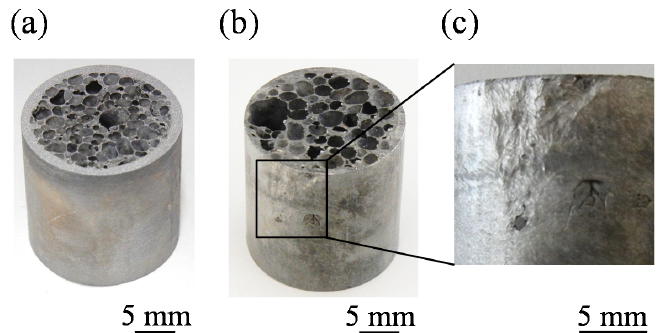
Figure 4. Fabricated ADC12 ‐ foam ‐ filled A1050 tube with holding times of ( a ) t H = 8.5 min and ( b ) t H = 11 min; ( c ) Enlargement of part of ( b ).